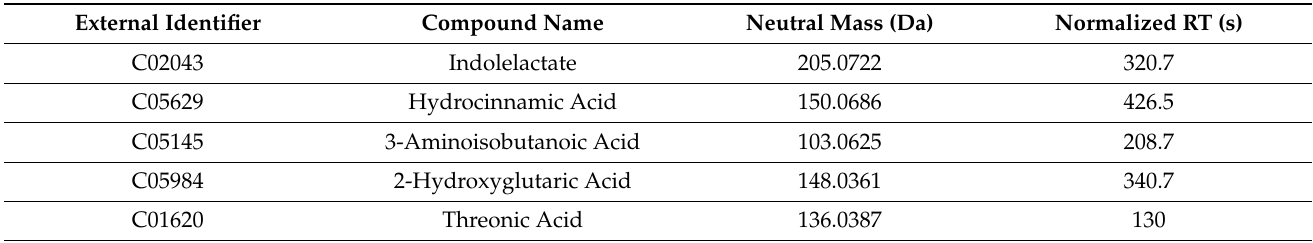
Table 1. Positively identified (tier 1) significantly abundant metabolites in